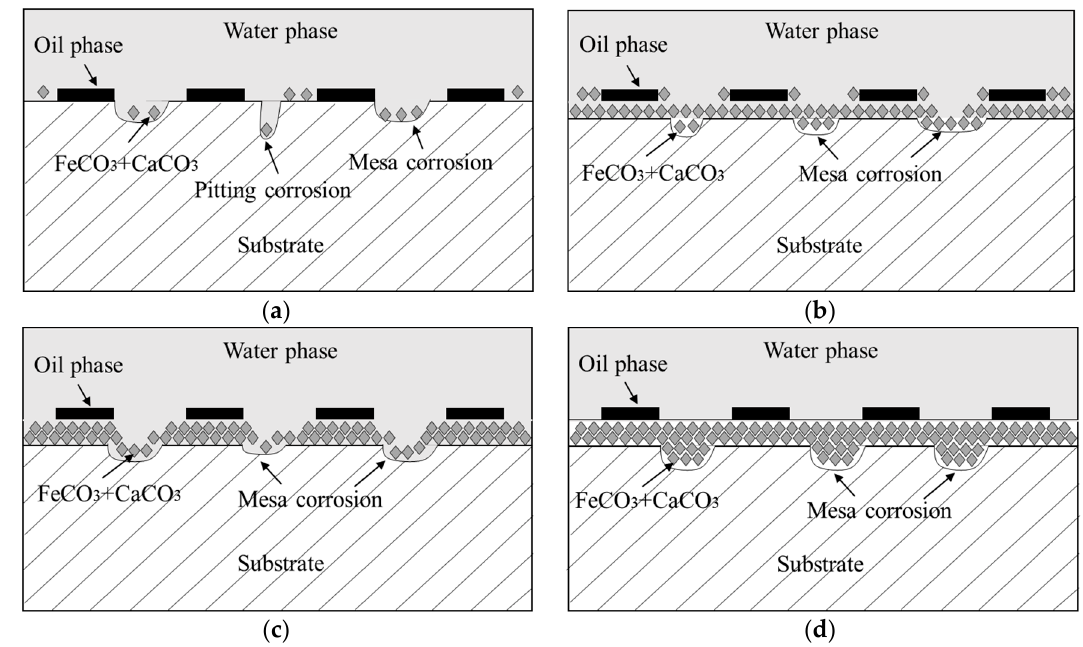
Figure 15. Schematic models for the localized corrosion of J55 steel in the different CO 2 /30% crude oil/brine mixtures: ( a ) model I: generating scattered corrosion scale (Pco 2 = 0.5–1.5 MPa); ( b ) model II: gradually generating protective corrosion scale (Pco 2 = 1.5–5.0 MPa); ( c ) model III: dissolving protective corrosion scale (Pco 2 = 5.0–9.0 MPa); and ( d ) model IV: generating protective corrosion scale (Pco 2 = 9.0–15.0 MPa).